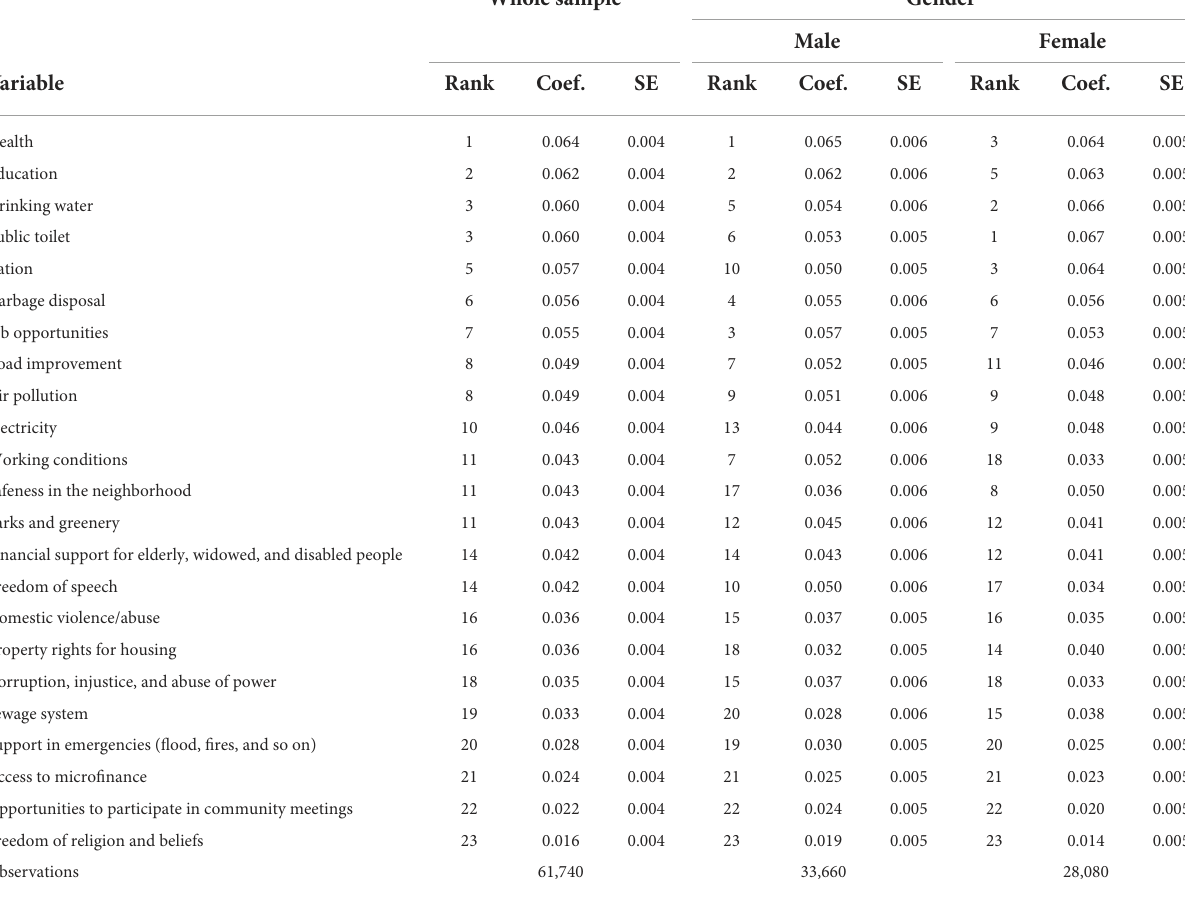
Whole sample Gender Male Female